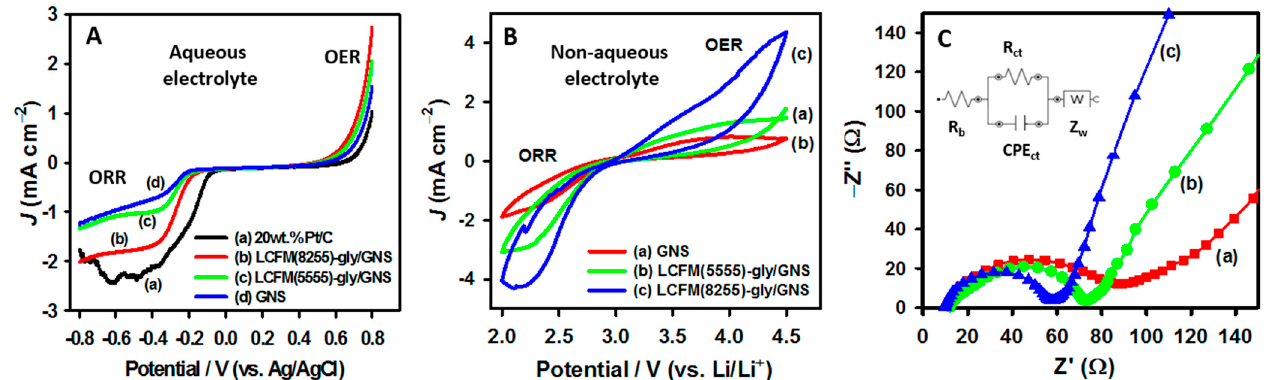
Figure 6. ( A ). LSVs for ORR and OER kinetics at various electrodes recorded in O 2 -saturated 0.1 M KOH; Scan rate: 20 mV s − 1 ; Rotation speed: 1600 rpm, ( B ). CVs for ORR and OER kinetics using ( a ) GNS, ( b ) LCFM(5555)-gly/GNS and ( c ) LCFM(8255)-gly/GNS-based Li-O 2 cells in 1 M LiTFSI-TEGDME + 0.5 M LiI at a scan rate of 1 mV s − 1 , ( C ). EIS data for electron transfer properties of ( a ) GNS, ( b ) LCFM(5555)-gly/GNS and ( c ) LCFM(8255)-gly/GNS-based Li-O 2 cells.